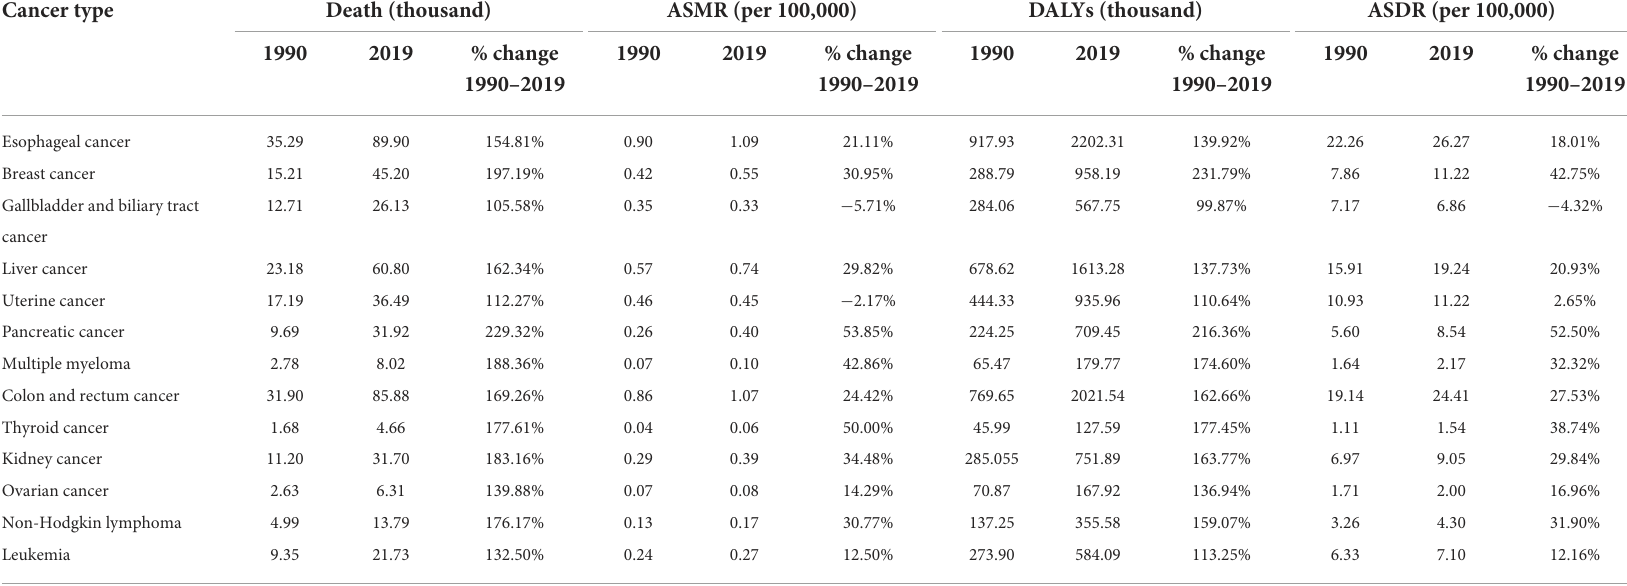
TABLE 3 Global deaths and DALYs of cancer attributable to high body mass index in 2019 and percentage change from 1990 to 2019 by cancer type. Cancer type Death (thousand) ASMR (per 100,000) DALYs (thousand) ASDR (per 100,000)